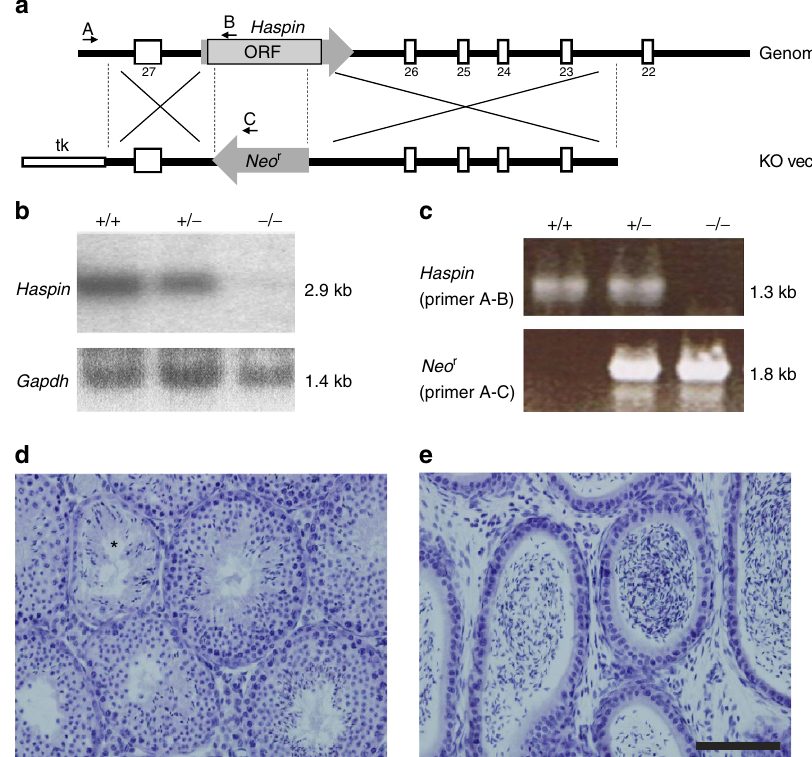
Figure 7 | Haspin KO mice are viable but show testicular abnormalities. ( a ) Schematic representation of the methods used for gene targeting of the Haspin genome. The gene-targeting construct contained Neor (grey arrow). Open boxes indicate exons of intergrin alphaE and TK. Black arrows indicate the primers used in the PCR for determining genotypes. ( b ) Northern blotting for Haspin expression. Haspin transcripts were not detected in testes from Haspin (cid:2) / (cid:2) mice. Gapdh cDNA was used as an internal control. Nucleotide sizes are indicated on the right. ( c ) Genotyping of mice using PCR: þ / þ (wild-type), þ / (cid:2) (heterozygous mutant), (cid:2) / (cid:2) (homozygous mutant). ( d ) Representative haematoxylin- and eosin-stained testicular sections of Haspin (cid:2) / (cid:2) mice. The asterisk indicates a tubule with disordered germ cells. ( e ) Hematoxylin- and eosin-stained epididymis of Haspin (cid:2) / (cid:2) mice. Scale bar, 100 m m.